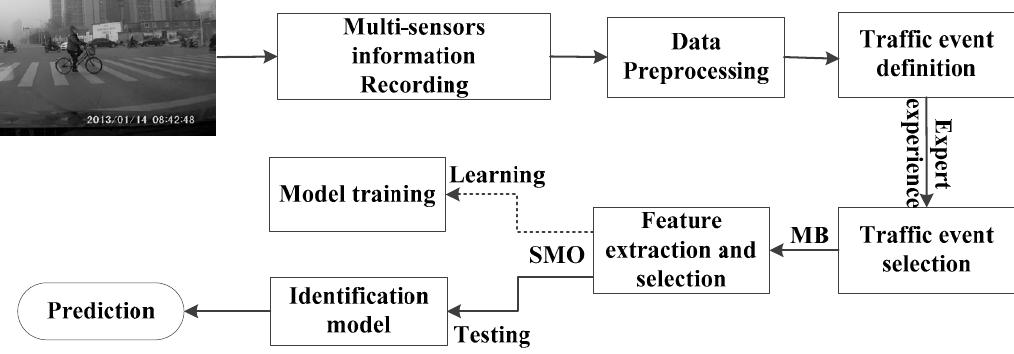
Figure 1. The proposed system for predicting hazardous traffic events.